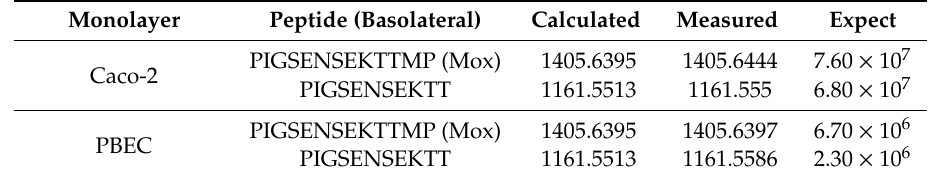
Table 3. Peptides identified on the basolateral side of Caco-2 and porcine brain endothelial cell (PBEC) monolayers after the synthetic peptide PIGSENSEKTTMPLW was added to the apical compartment.